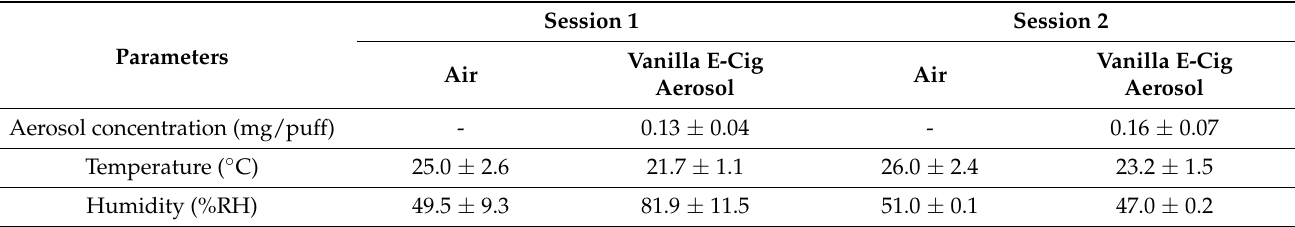
Table 1. In utero vanilla-flavored ENDS aerosols exposure